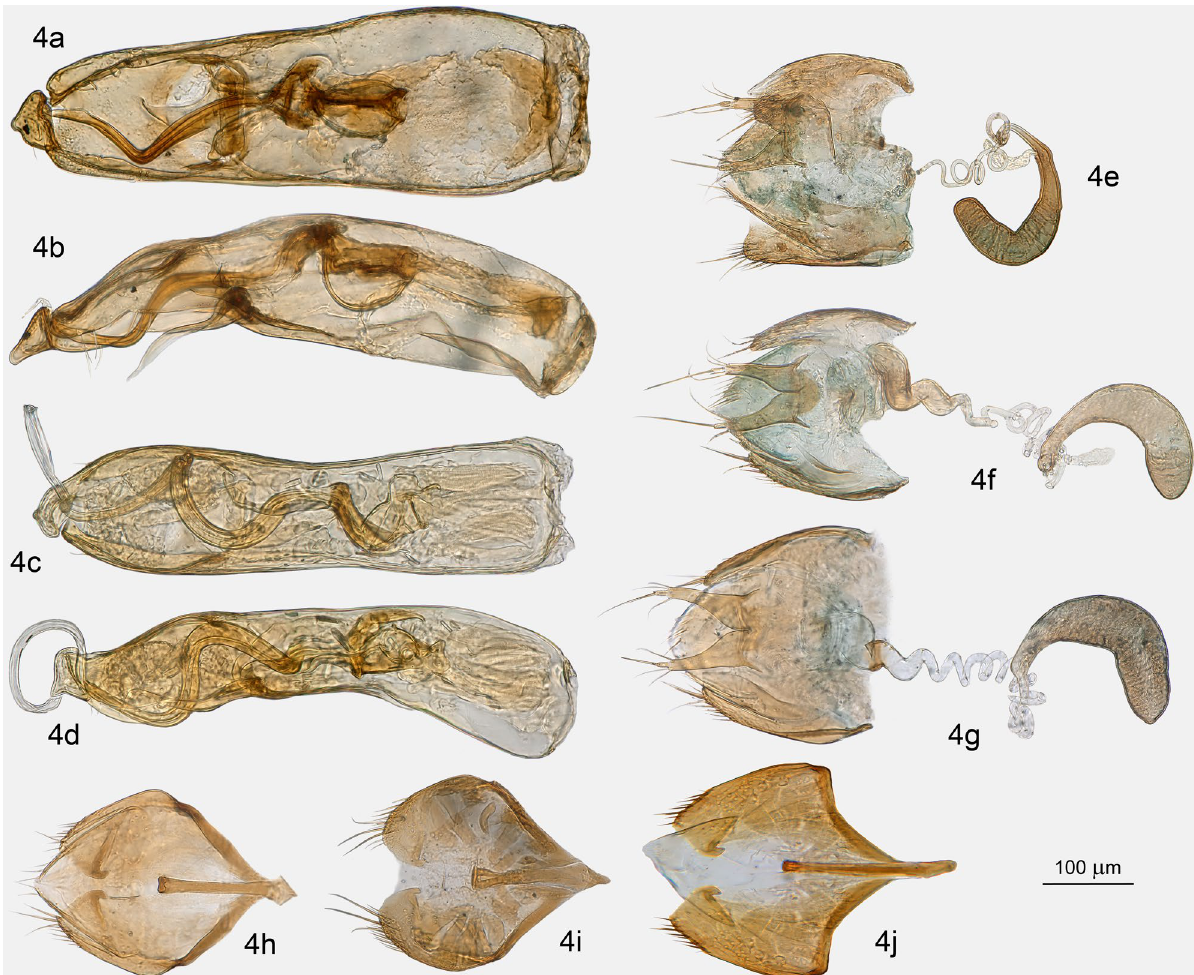
Figure 4. Genus Proptomaphaginus , genital structures. ( a ) P. microps , aedeagus dorsal view. ( b ) P. microps , aedeagus lateral view. ( c ) P. reddelli , aedeagus dorsal view. ( d ) P. reddelli , aedeagus lateral view. ( e ) P. puertoricensis , female genital segment. ( f ) P. hispaniolensis , female genital segment. ( g ) P. apodemus , female genital segment. ( h ) P. apodemus , male genital segment. ( i ) P. puertoricensis , male genital segment. ( j ) P. hispaniolensis , male genital